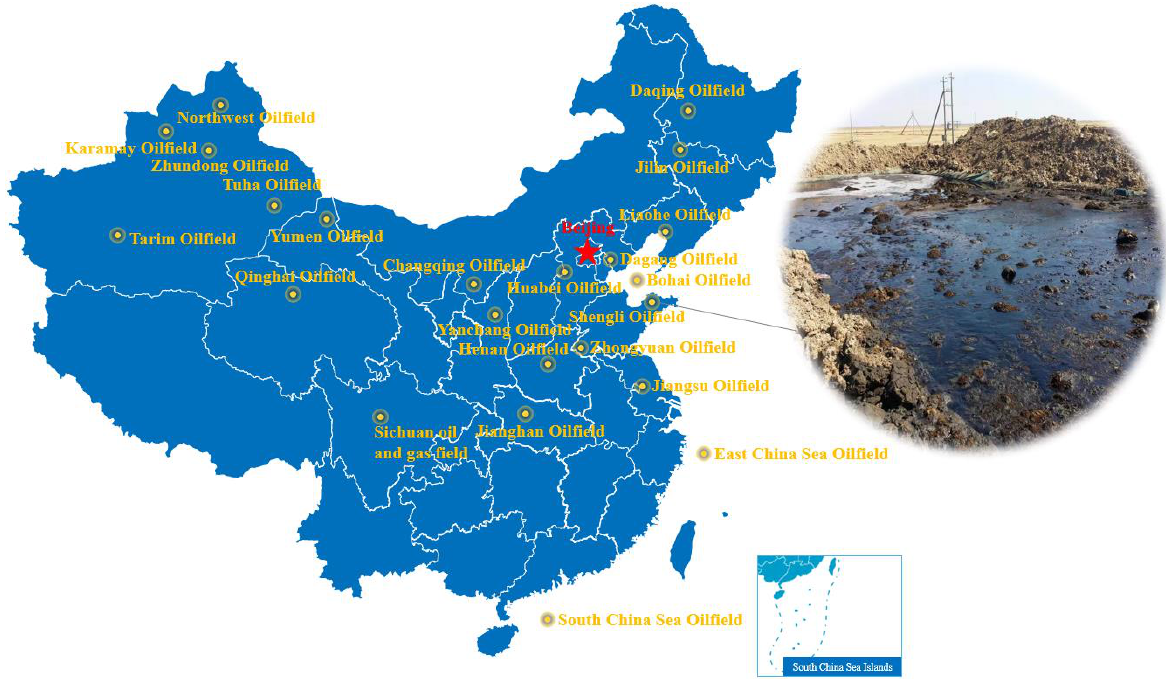
Figure 2. Oily sludge site in oilfield.